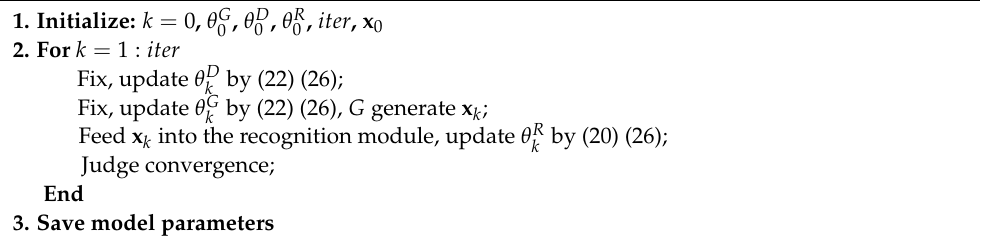
Algorithm 1. Iterative alternating training process of the IDR-Net